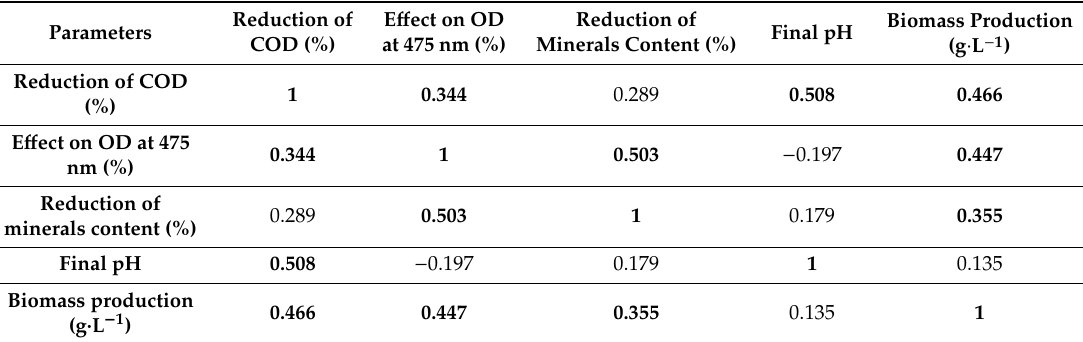
Table 2. Pearson correlation matrix.